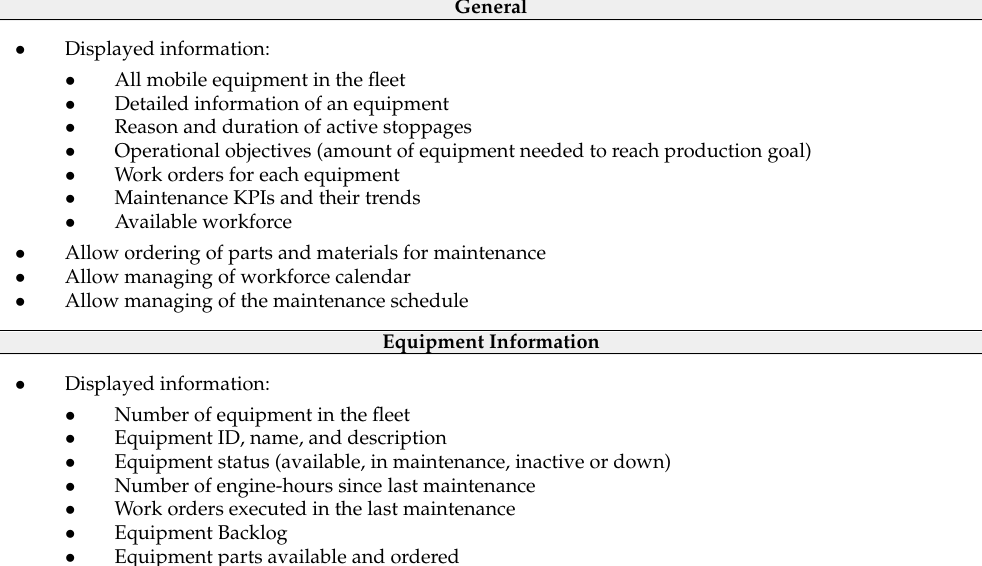
Table 6. Requirements and guidelines for a decision support